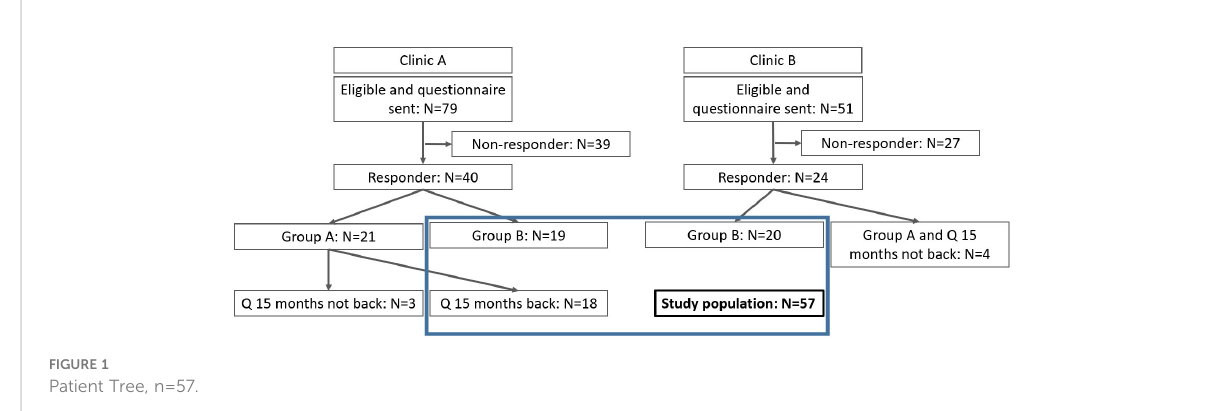
TABLE 1 Patient characteristics strati fi ed by recruiting clinic (n=57). Clinic A Clinic B Total p-value*